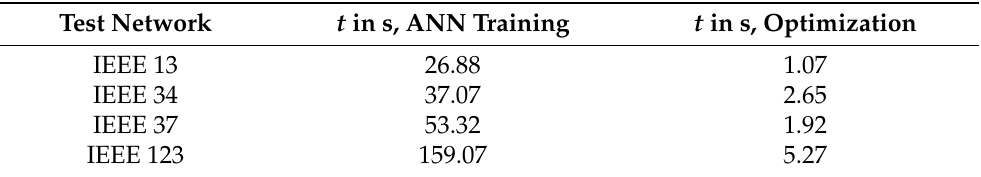
Table 5. Computational times of ANN training and optimization.